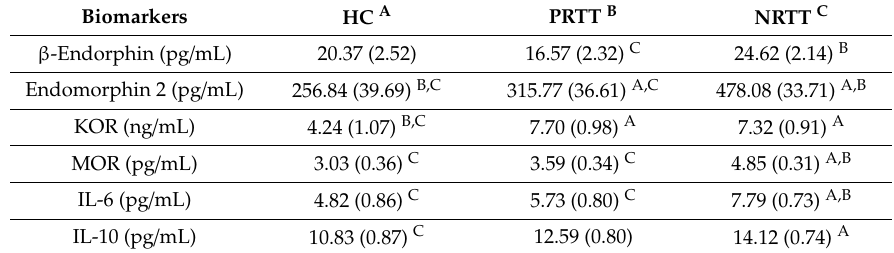
Table 4. Model-generated estimated marginal means values (SE) of the biomarkers in partial responders to treatment (PRTT), non-responders to treatment (NRTT) and healthy controls (HC).